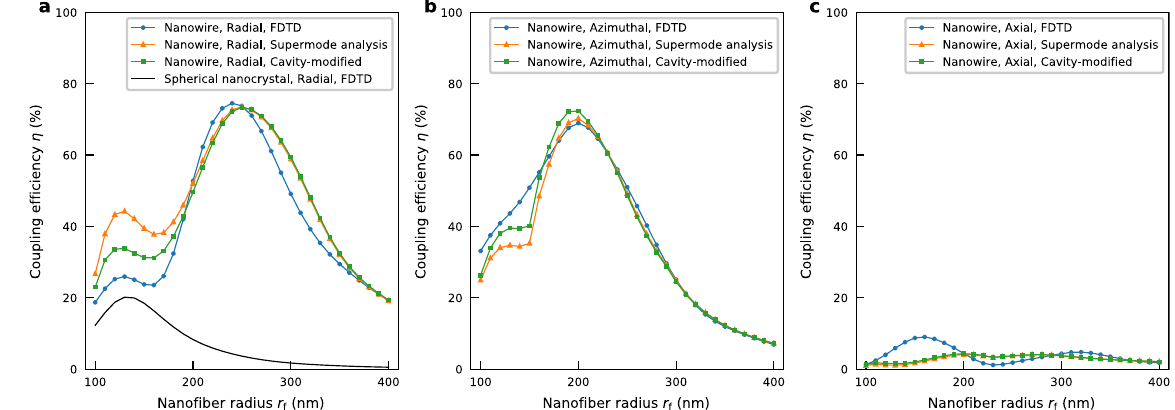
Figure 3. Dependence of the coupling efficiency on the dipole polarizations. ( a ) Radial polarization. ( b ) Azimuthal polarization. ( c ) Axial polarization. The circles, triangles, and squares represent the FDTD, supermode analysis (based on the model in ref. 40 ), and additional cavity-modified (based on the model in ref. 57 ) results, respectively. The nanowire radius r d = 85 nm and the nanowire length L d = 3.6 μ m are fixed. For comparison, the black solid line in Fig. 3a represents the FDTD result for the case of the spherical diamond nanocrystal (the radius r nc = 85 nm) with radial